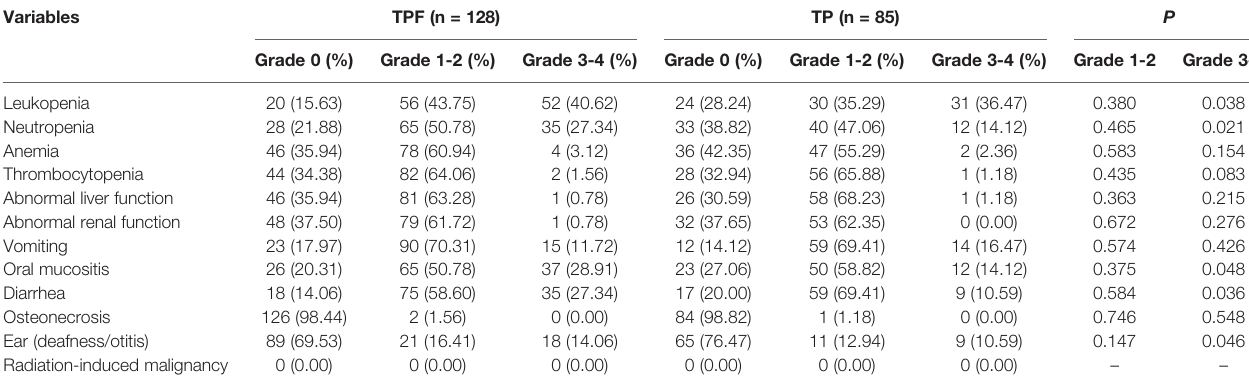
TABLE 4 | Treatment-related toxicities between the TPF and TP groups.